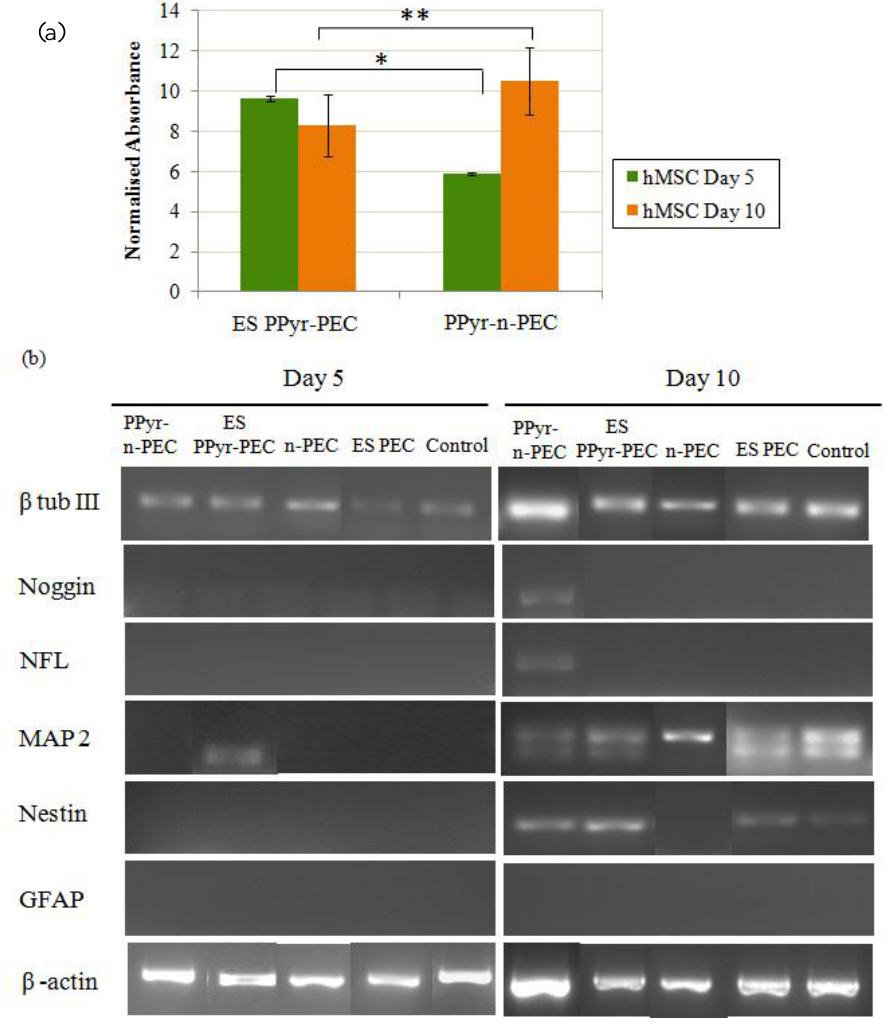
Figure 3. ( a ) hMSC viability and proliferation results at day 5 and day 10. Statistical significance: * p < 0.0001 (between ES PPy-PEC and PPy-n-PEC samples at day 5), ** p < 0.005 (between ES PPy-PEC and PPy-n-PEC samples at day 10) ( b ) mRNA expressions of hMSCs at day 5 and day 10. Control refers to hMSCs seeded on glass